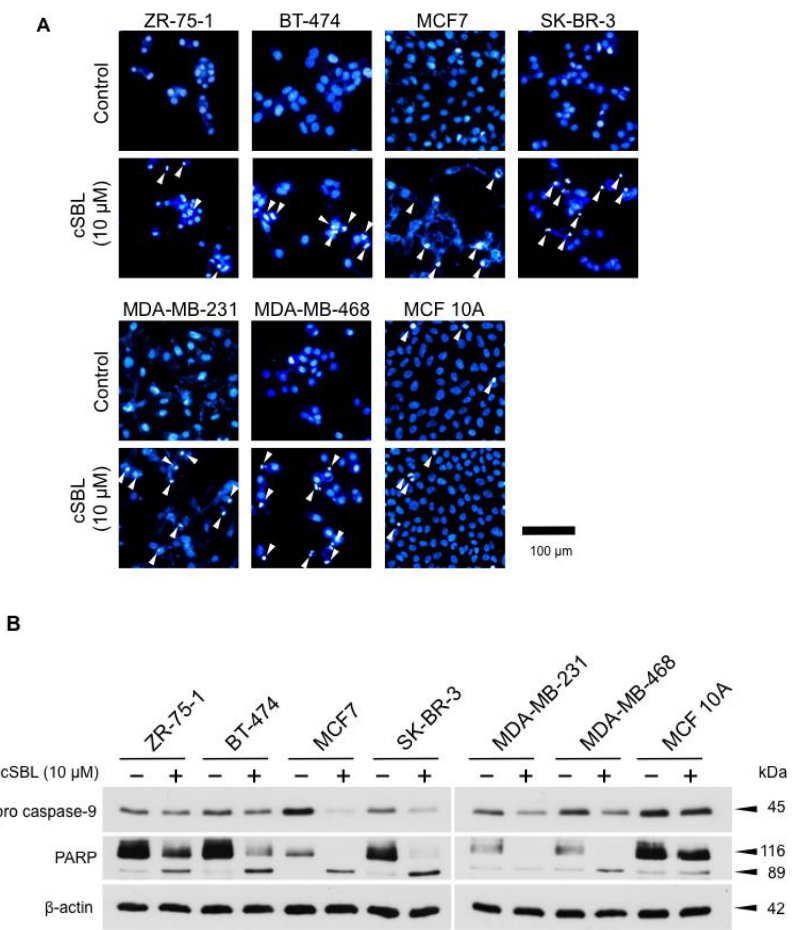
Figure 2. Apoptosis induction in breast cancer cell lines (ZR-75-1, BT-474, MCF7, SK-BR-3, MDA-MB- 231, and MDA-MB-468) treated with cSBL. ( A ) Morphological changes of nuclei in cSBL-treated cells. Cells were treated with cSBL (10 µM) for 72 h and stained with Hoechst 33342. Nuclei were observed using a fluorescent microscope. Arrows indicate apoptotic nuclei. Magnification, 20×. ( B ) Cells